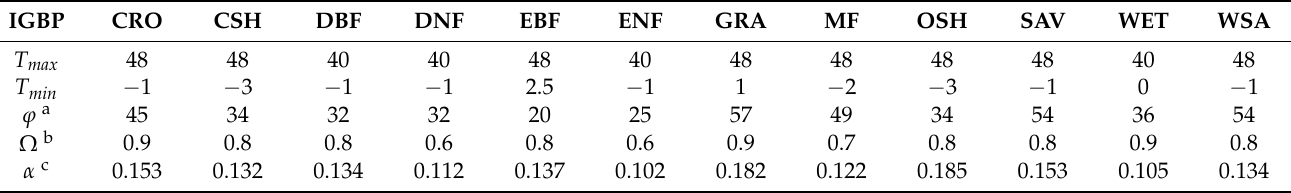
Table 2. Parameters T max , T min , clumping index ( Ω ), and albedo( α ) of different vegetation types. The vegetation types include cropland (CRO), closed shrubland (CSH), deciduous broadleaf forest (DBF), deciduous needleleaf forest (DNF), evergreen broadleaf forest (EBF), evergreen needleleaf forest (ENF), grassland (GRA), mixed forest (MF), open shrubland (OSH), savanna (SAV), permanent wetland (WET), and woody savanna